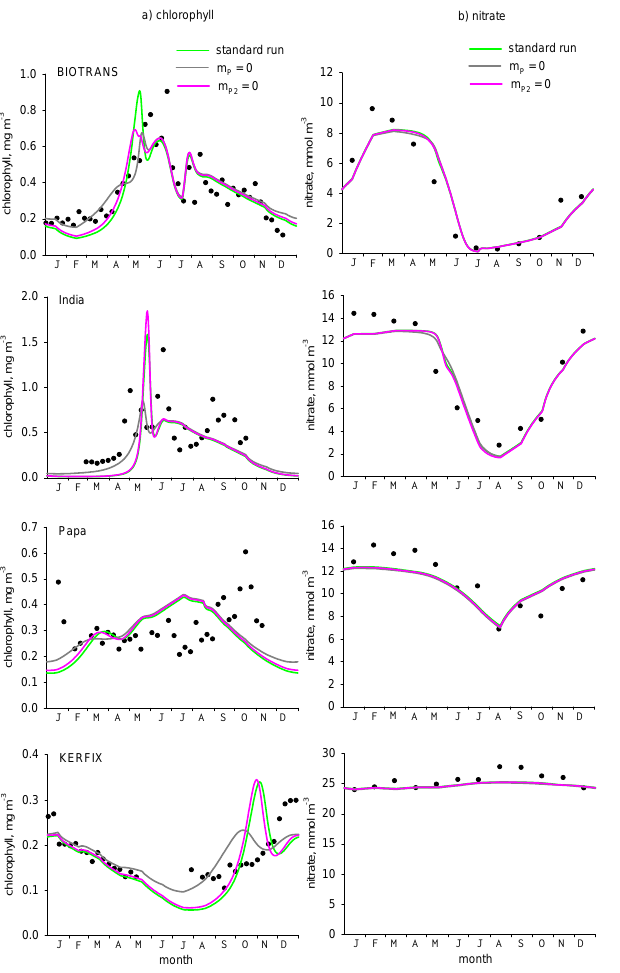
Figure 22. Simulations for all four stations showing model sensitiv- ity for zooplankton mortality. Parameters m Z (linear mortality) and m Z 2 (quadratic mortality) were set to zero in turn. (a) Chlorophyll, (b)